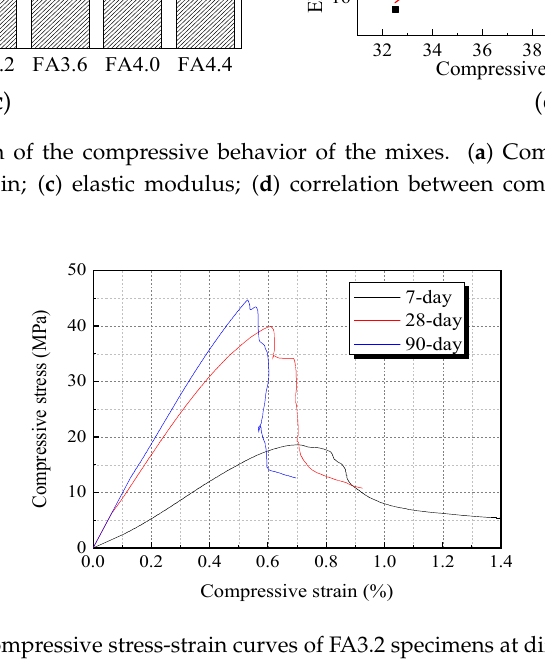
Figure 9. Compressive stress-strain curves of FA3.2 specimens at different ages.